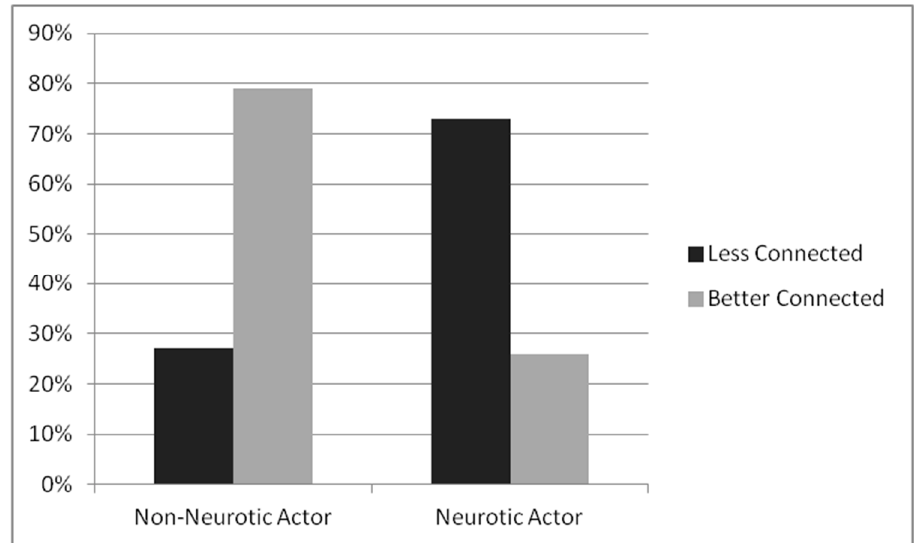
Figure 3. Study 2—Percentage of candidates assigned to less-connected and better-connected positions.